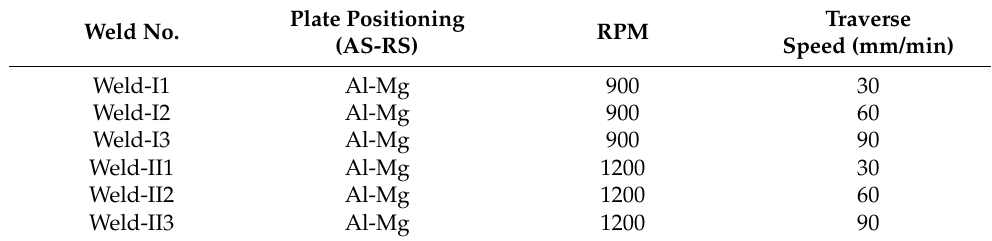
Table 3. Details of the experimental process parameters and plate positions. Weld